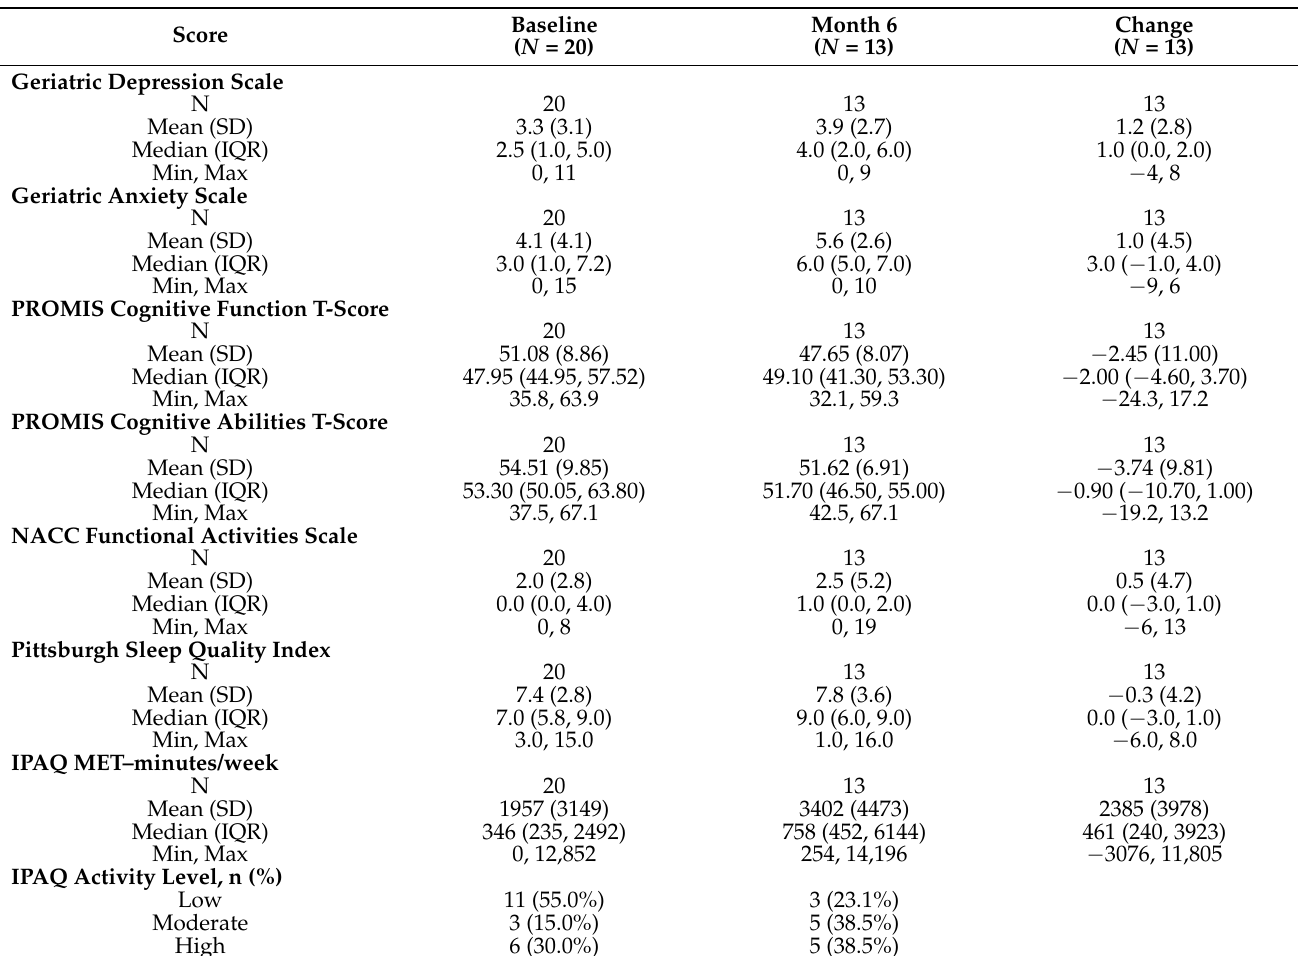
Table A1. Self-report instruments: overall scores.